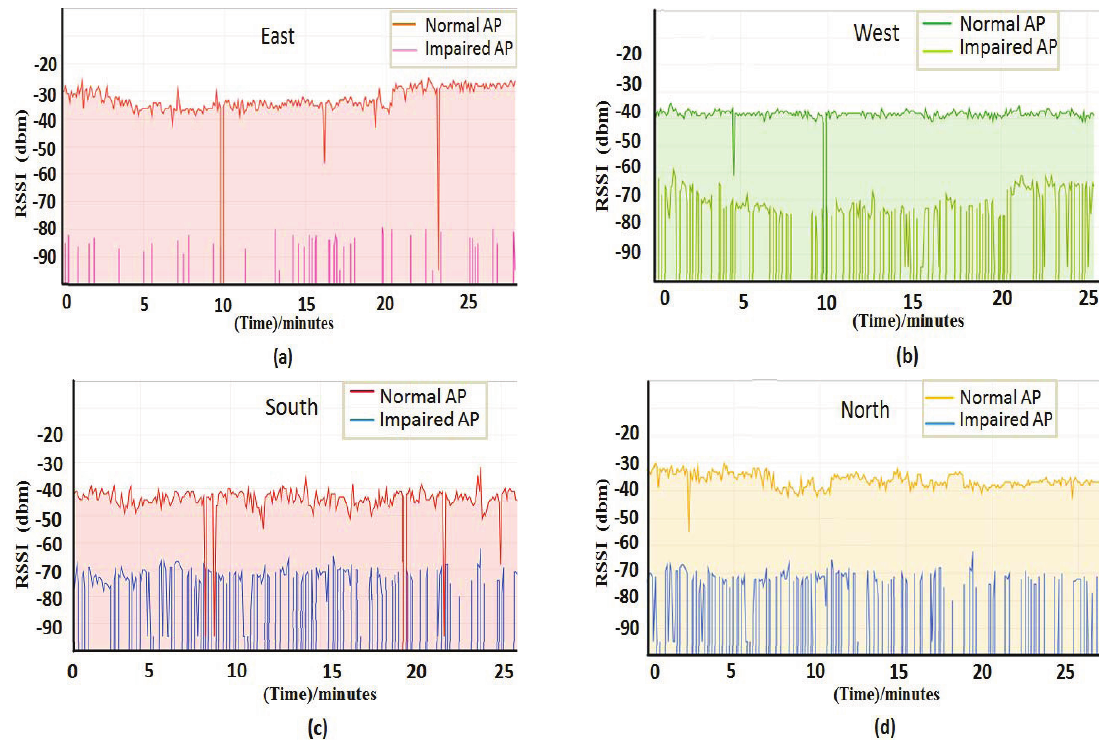
Figure 6. Impact of impaired AP on RSSI. ( a ) RSSI that are measured in the east. ( b ) RSSI that are measured in the west. ( c ) RSSI that are measured in the south. ( d ) RSSI that are measured in the